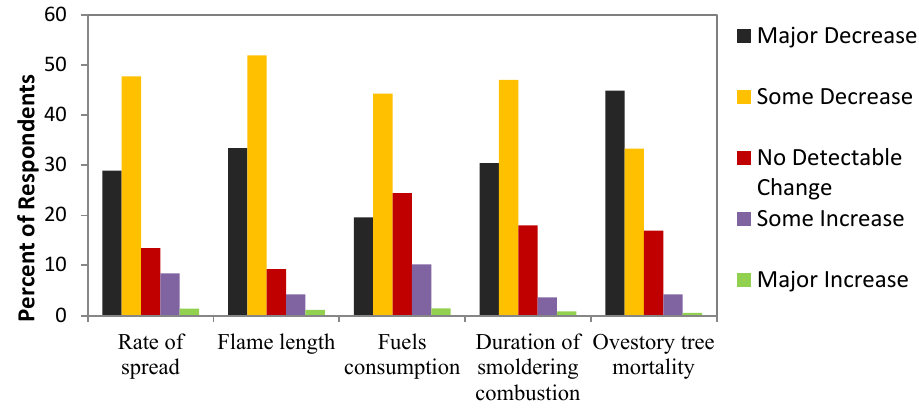
Figure 5. Response rates answering the question, “Where a wildfire has occurred in a recently burned area (1–3 years), how have the following fire behavior variables and fire effects been changed (if at all)?”